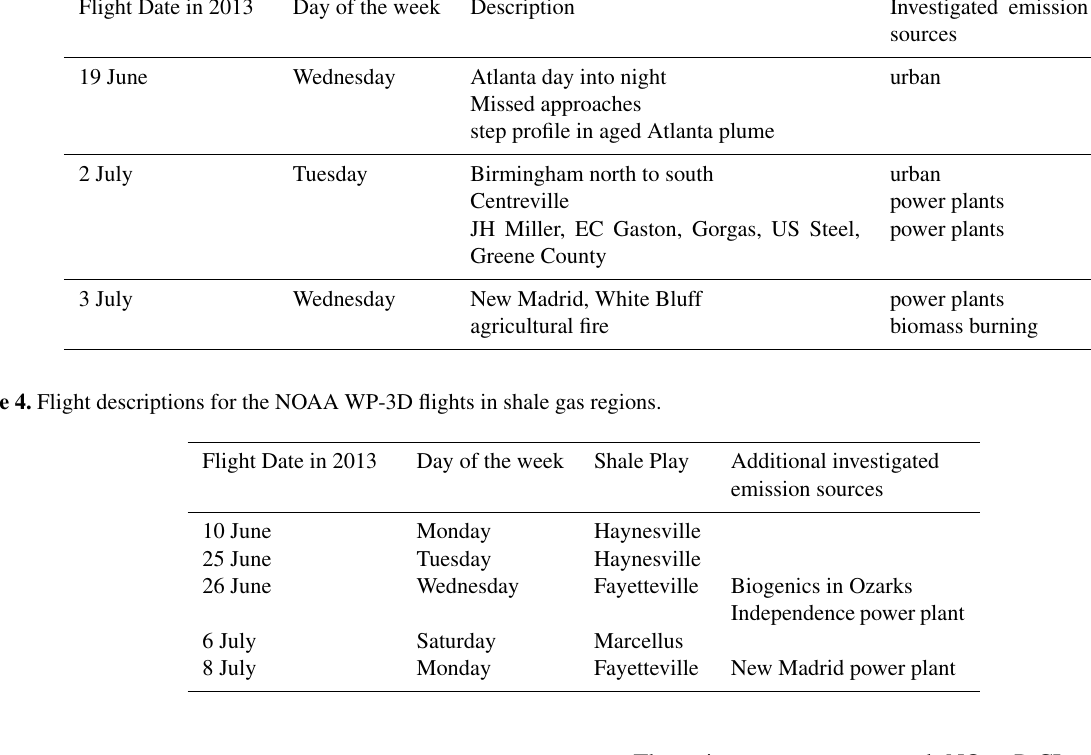
Three instruments measured NO 2 : P-CL, CRDS, and ACES. The agreement between CRDS and ACES with the standard P-CL technique, as shown in Fig. 3, was on average ear correlation coefficient ( R 2 ) of 0.99 and 0.93,